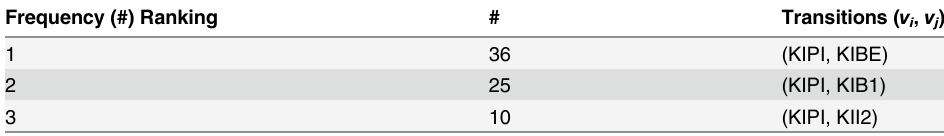
Table 6. Most frequently observed transitions between nursing organizational